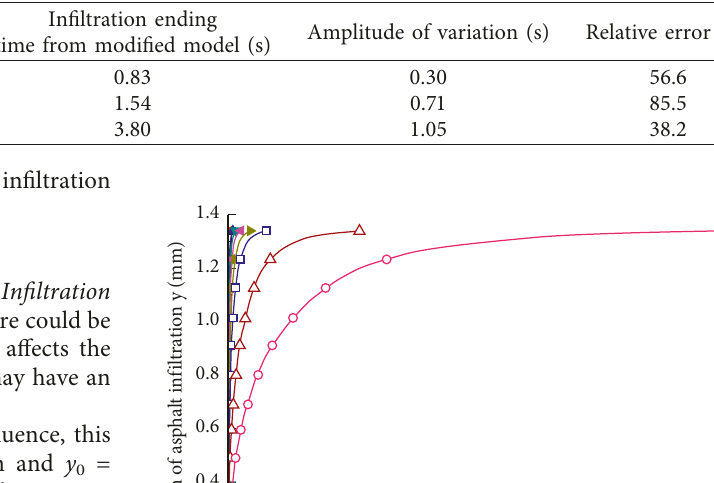
Figure 4: Comparison of infiltration curves deduced from the basic and modified models. Table 4: Comparison of infiltration ending time deduced from basic and modified model.